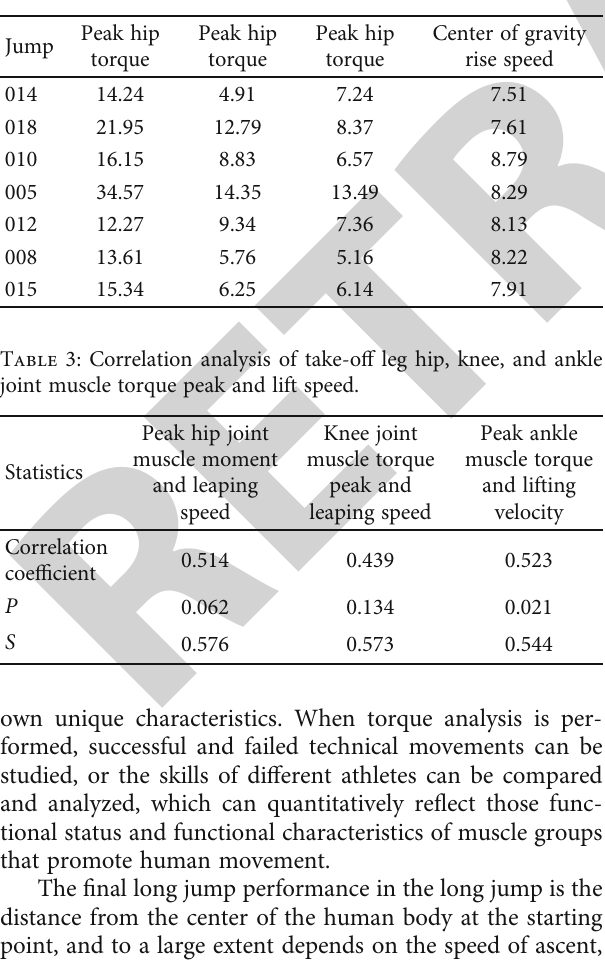
Figure 6: Detailed schematic diagram of long jump take-o ff action. Table 2: Take-o ff leg hip, knee, and ankle joint muscle torque changes and take-o ff speed.